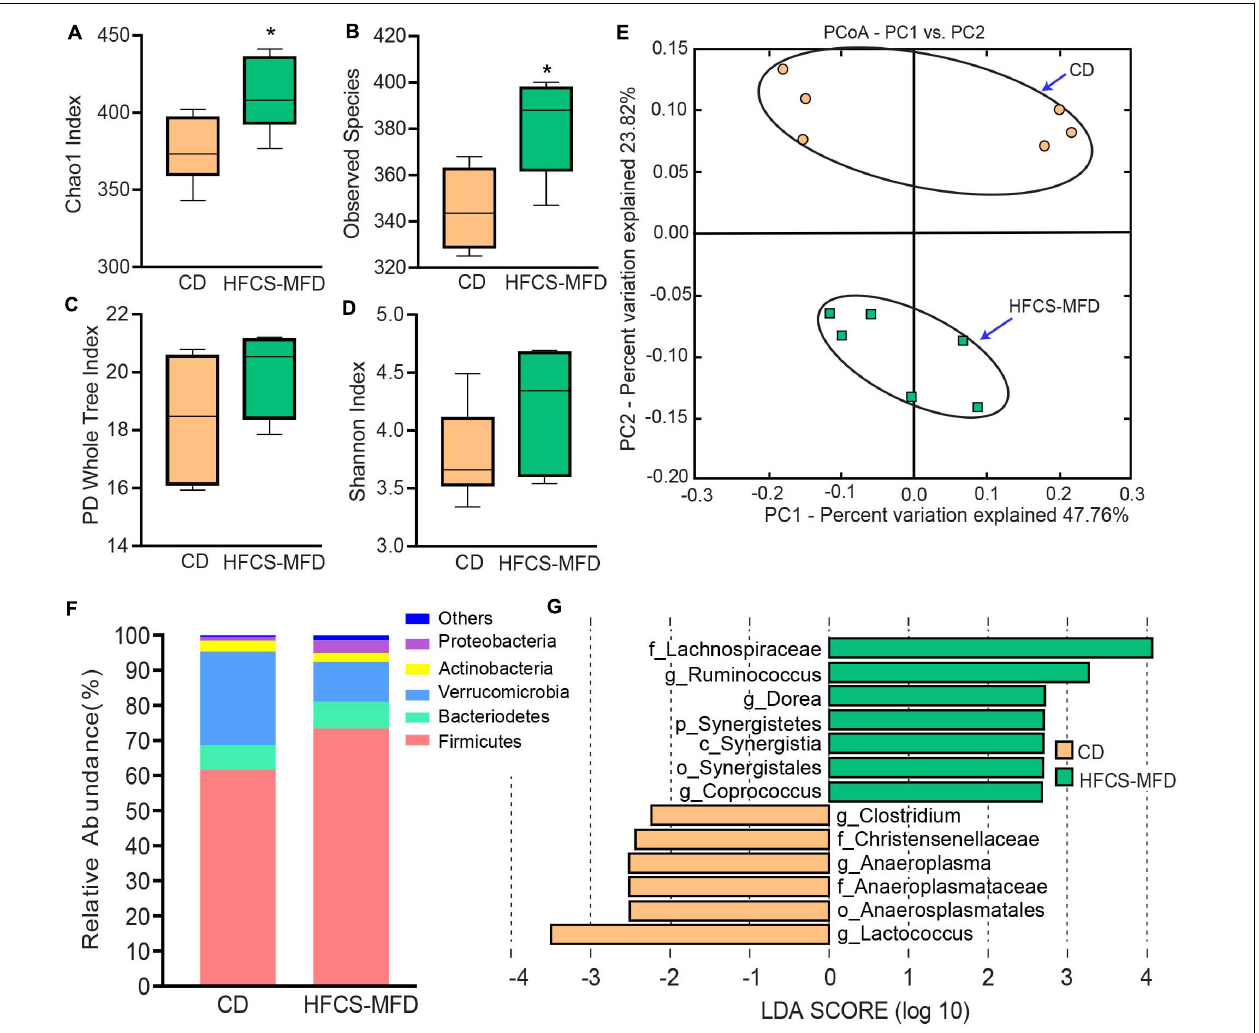
FIGURE 3 | HFCS-MFD consumption alters gut microbiota composition. Box plots showing differences in the caecal microbiome alpha diversity indices between the CD and HFCS-MFD groups according to the (A) Chao1 (B) , Observed Species (C) PD Whole Tree and (D) Shannon diversity indices based on OTU levels. ( n = 6 per group; * p < 0.05 Wilcoxon Rank Sum test). (E) Principal Coordinate Analysis (PCoA) plot based on unweighted UniFrac distance between samples (F) Relative abundances of the bacterial communities at the phylum taxonomic rank among the CD and HFCS-MFD mice ( n = 6 per group) (G) Linear discriminant analysis (LDA) effect size (LEfSe) analysis of gut microbiota changes following consumption of 16 weeks of HFCS-MFD or CD ( p < 0.05; LDA > 2). The colors represent the group in which the indicated taxa are more abundant compared to the other